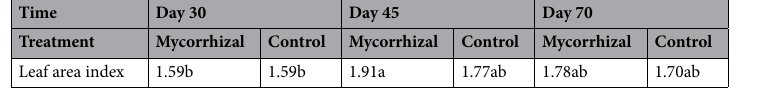
Table 1. Effects of mycorrhizal soil inoculation on leaf area index of peanut. Mean values not followed by the same letter are significantly different by least significant difference (LSD, p < 0.05).